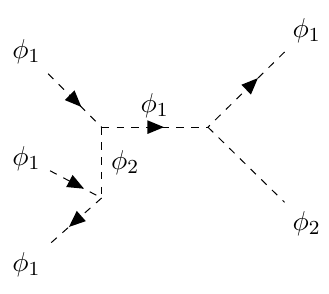
Figure 4 . Feynman diagram for 3